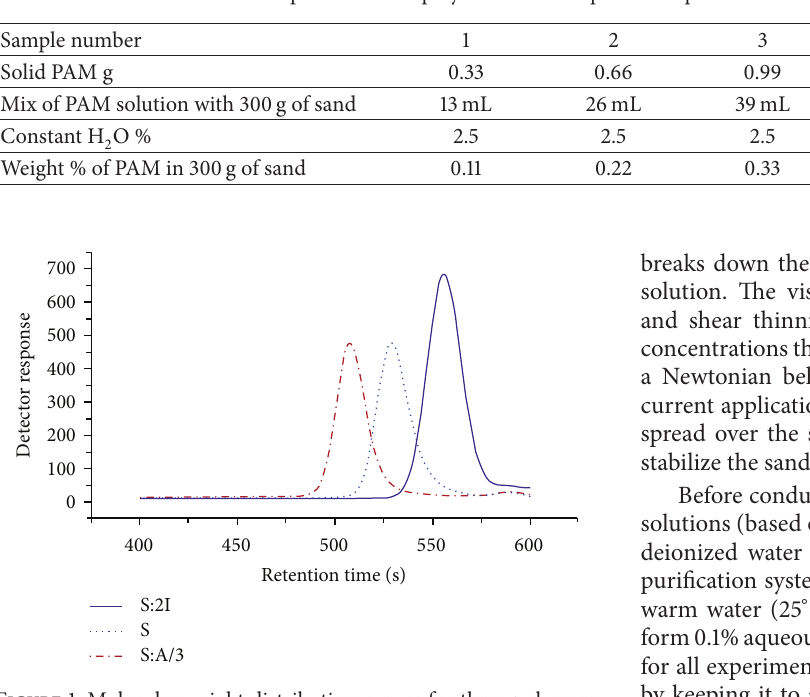
Figure 1: Molecular weight distribution curves for three polymers obtained in solution polymerization.